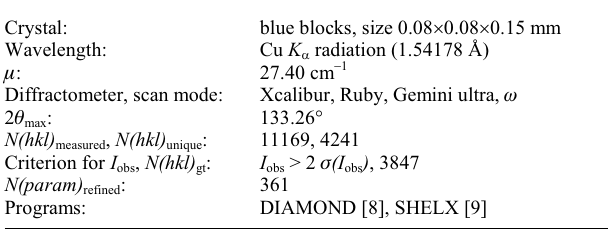
Table 1. Data collection and handling.